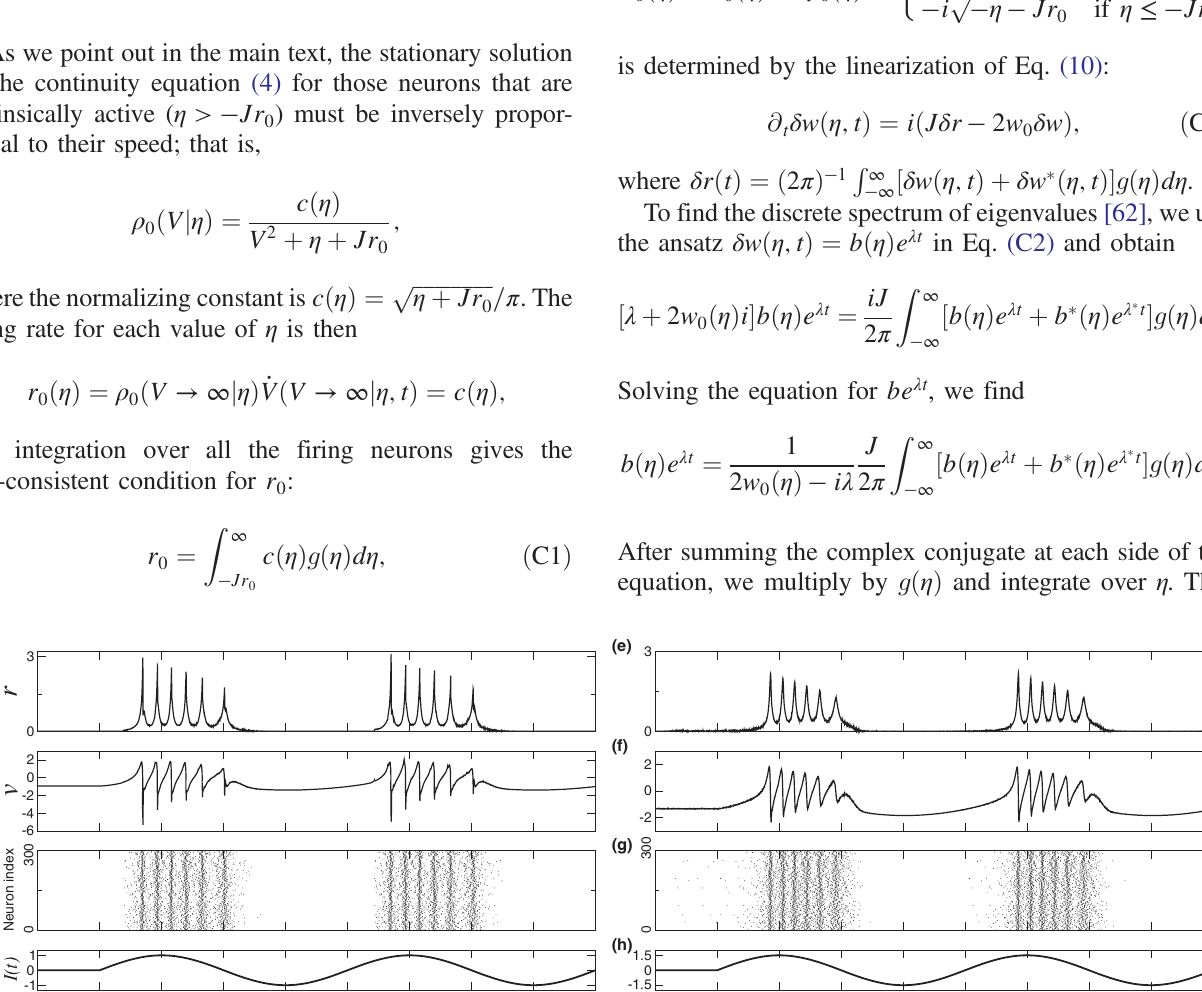
FIG. 5. Phase diagrams for (a) uniform and (b) Gaussian distributions of currents g ð η Þ . The cyan-shaded region represents the bistable region, with the solid lines corresponding to saddle- node bifurcations analytically obtained from Eqs. (C5) and (C6). Square symbols are estimates of the bifurcations ’ loci obtained by direct numerical simulations of N ¼ 10 4 QIF neurons. Triangle symbols indicate parameter values used in numerical simulations of Figs. 6 and 7.